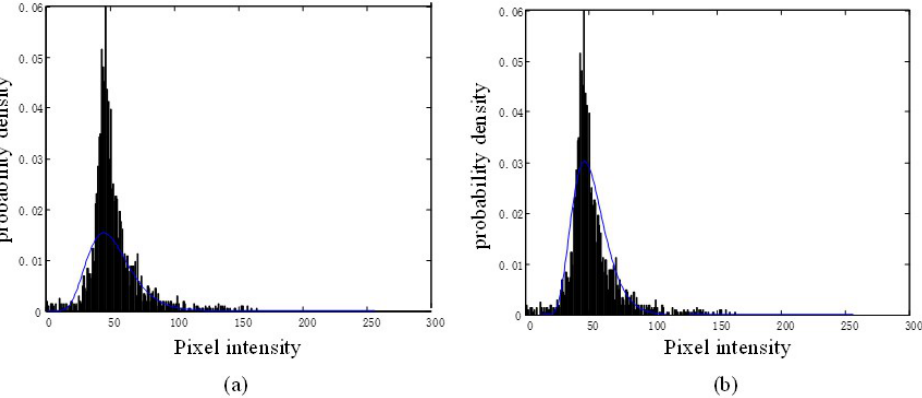
Figure 5. Comparison of fitting results of two models. ( a ) K-distribution model; ( b ) Mixture distribu- tion